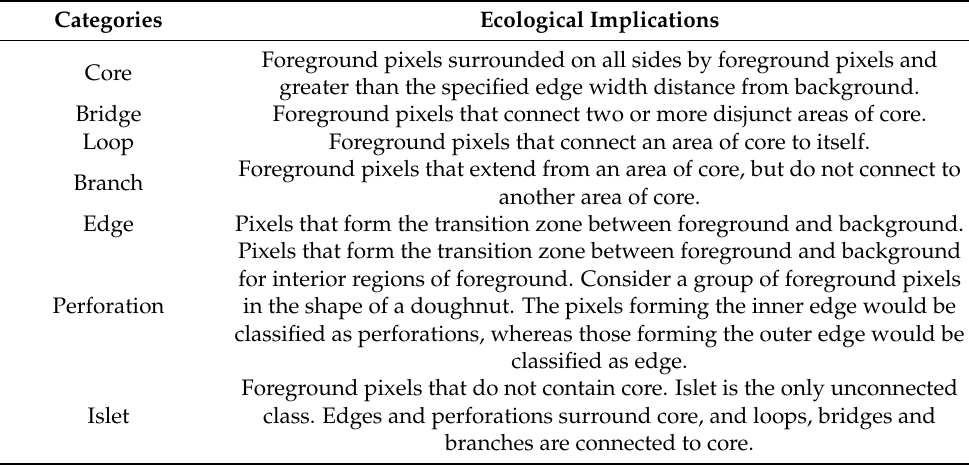
Table 1. Landscape categories and ecological implications based on MSPA